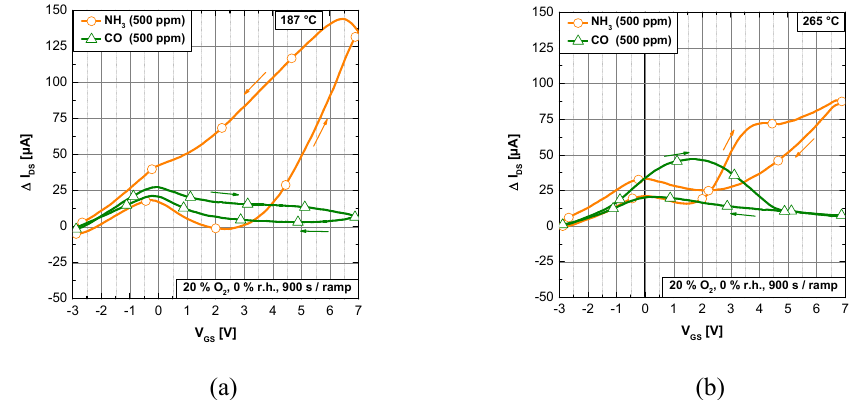
Figure 6. Hysteresis of ∆ I DS for CO (green, triangles) and NH 3 (orange, circles) in dry air (20% O 2 , 0% RH) at 187 ◦ C (a) and 265 ◦ C (b) .